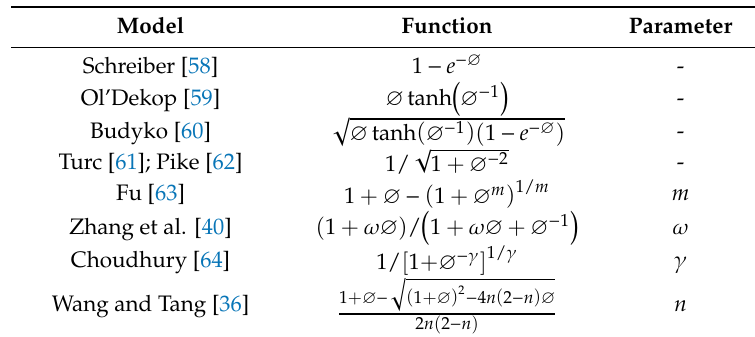
Table 2. Di ff erent equations collected from the previous studies based on the Budyko hypothesis.